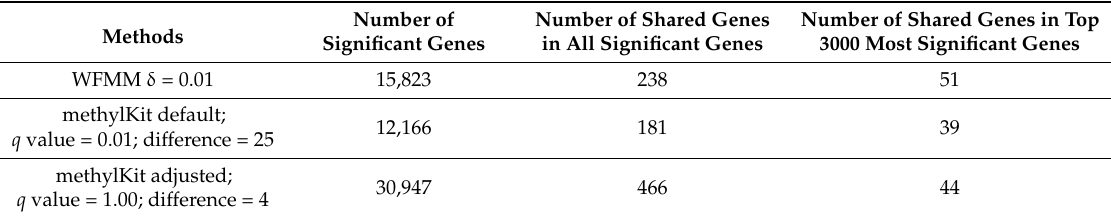
Table 3. Number of significant DMCs, and genes recognized by DAVID by applying WFMM with different pain sensitivity